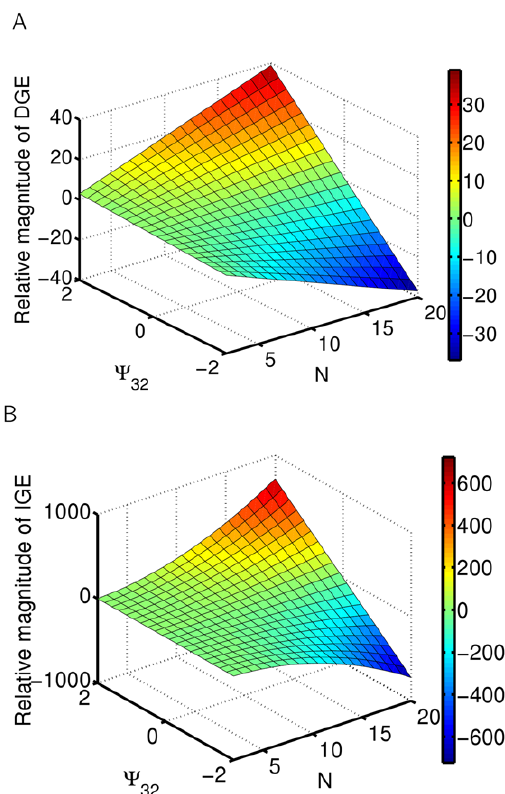
Figure 3. Interactions with feedback at the individual level: direct and indirect genetic effects. Dependence of the direct (A) and indirect (B) genetic effect on the strength of the interaction Y 32 (trait Y acting on trait Z) and group size N . Visualization of DGE and IGE of genes x and y acting on Z, as described in equation 2. Interaction, as depicted in Figure 1 B, with the interaction strength of X acting on Y set to Y 21 ~ 0 : 05 .